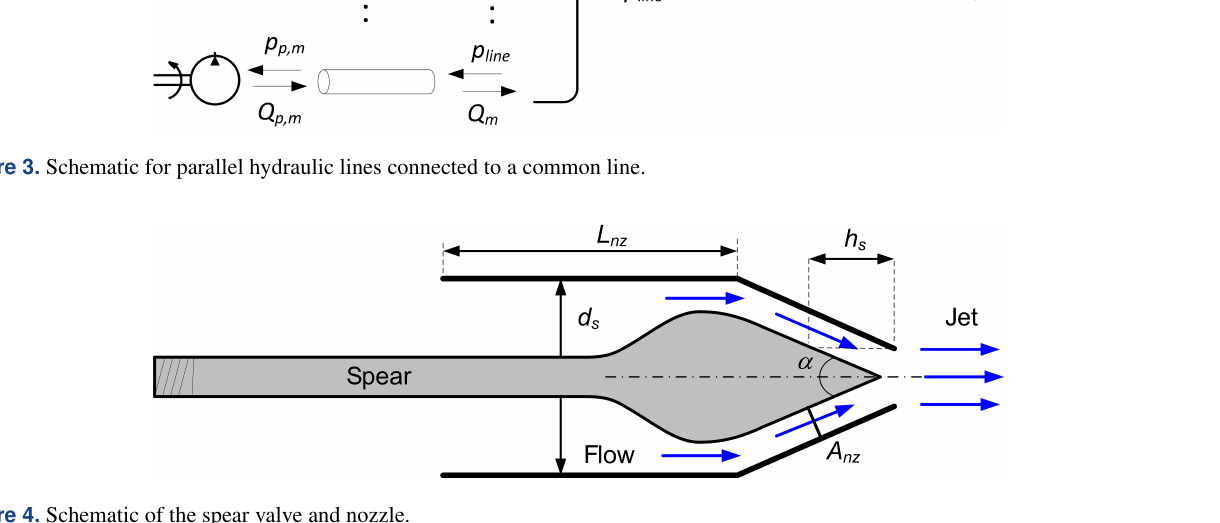
Figure 4. Schematic of the spear valve and